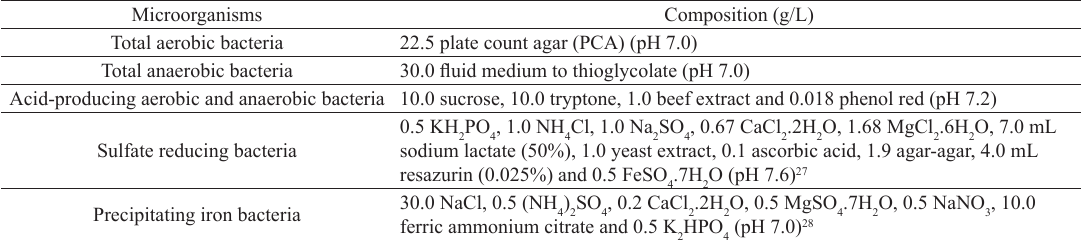
Table 3. Culture medium